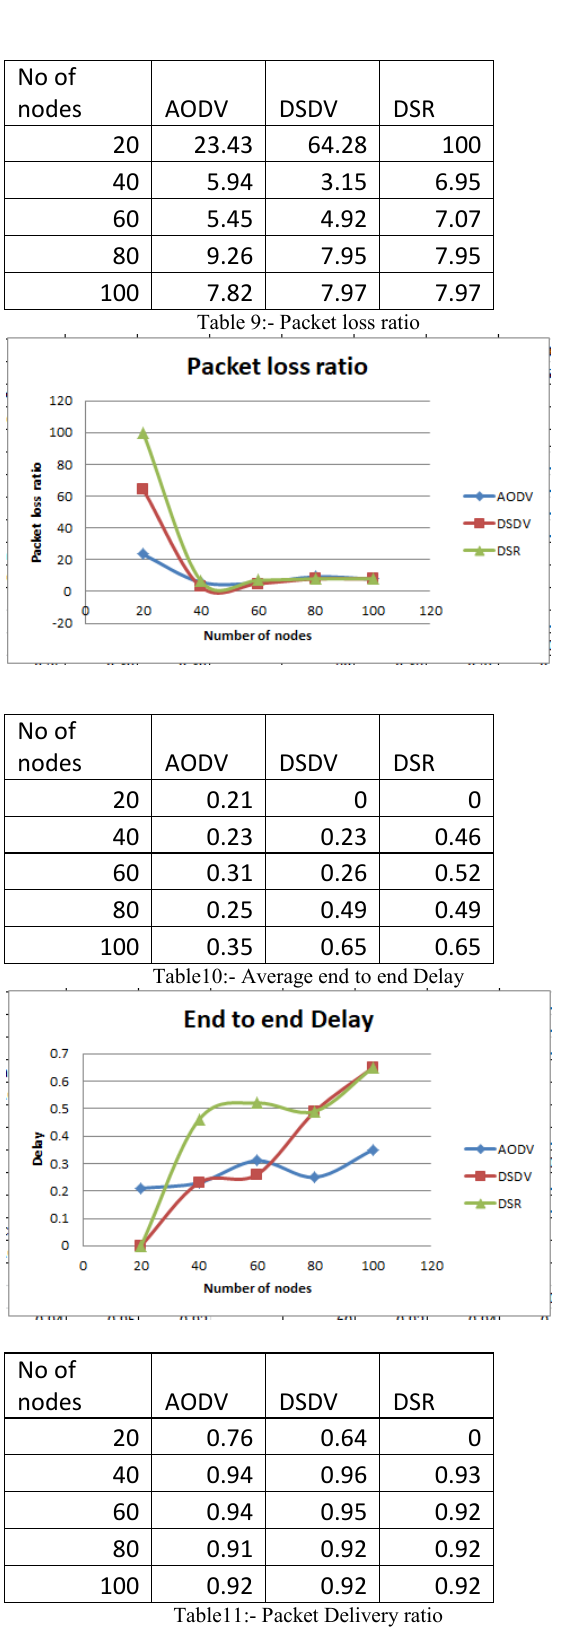
Table 9:- Packet loss ratio